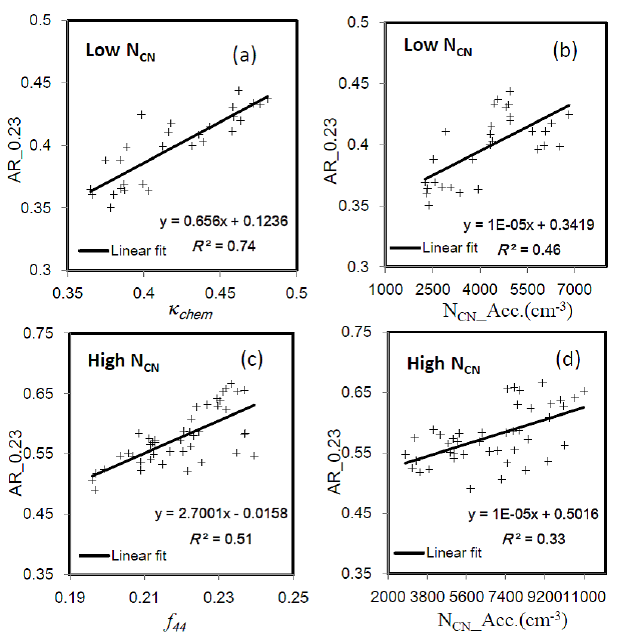
Figure 9. AR measured at SS = 0.23% as a function of (a) κ chem under background conditions, (b) accumulation mode N CN un- der background conditions, (c) f 44 under polluted conditions, and (d) accumulation mode N CN under polluted conditions. The accu- mulation mode size range is 130–700nm in this study.